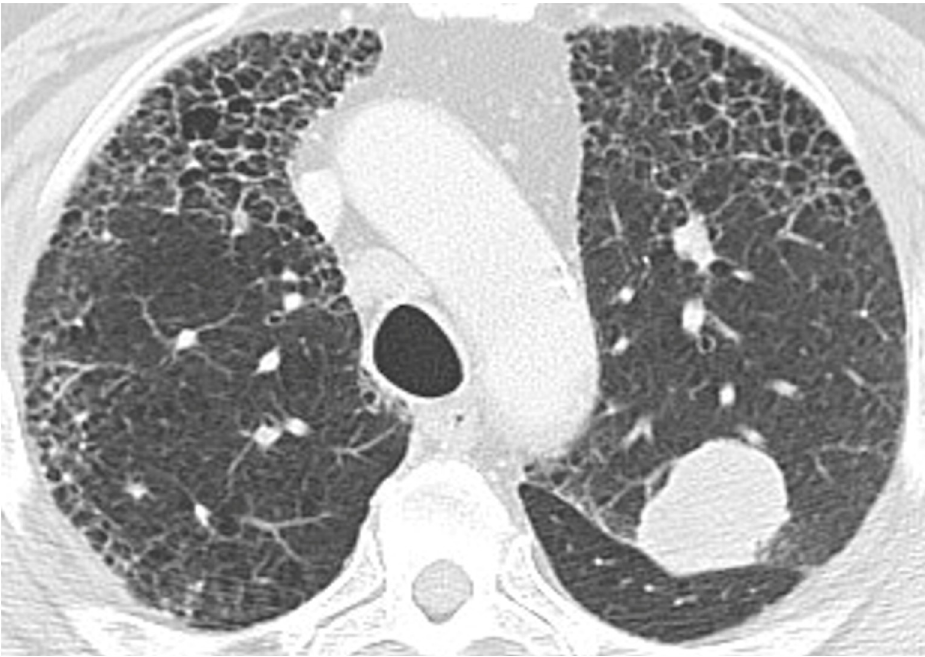
Fig 1. Squamous cell carcinoma and CT pattern typical for UIP. Axial CT image at the level of the upper lobes shows a left upper lobe squamous cell carcinoma and CT features of typical UIP.